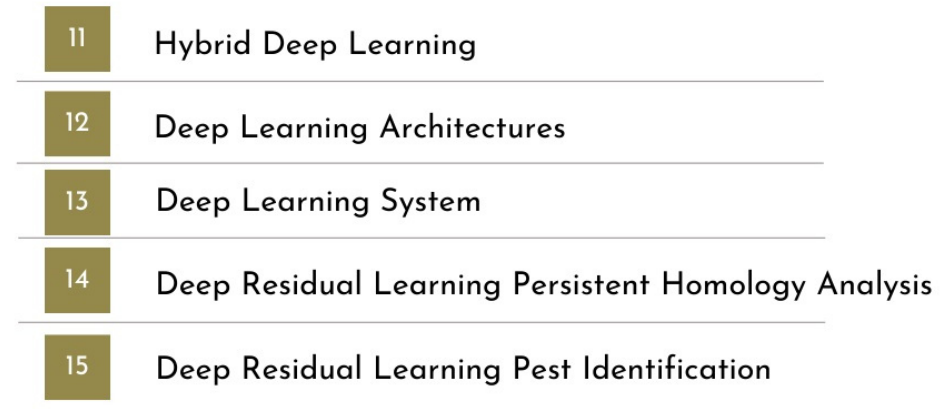
Figure 7. Next Five